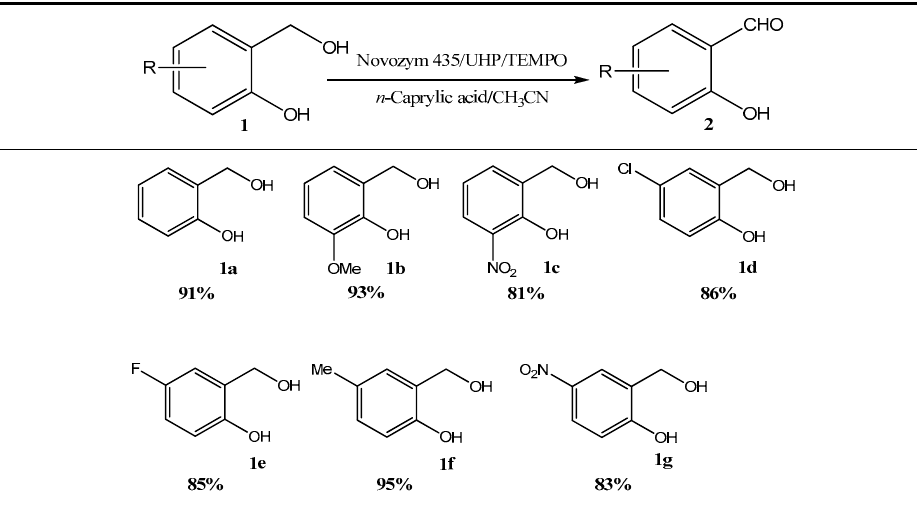
Table 4. The oxidation of substituted salicylic alcohols catalyzed by lipase.